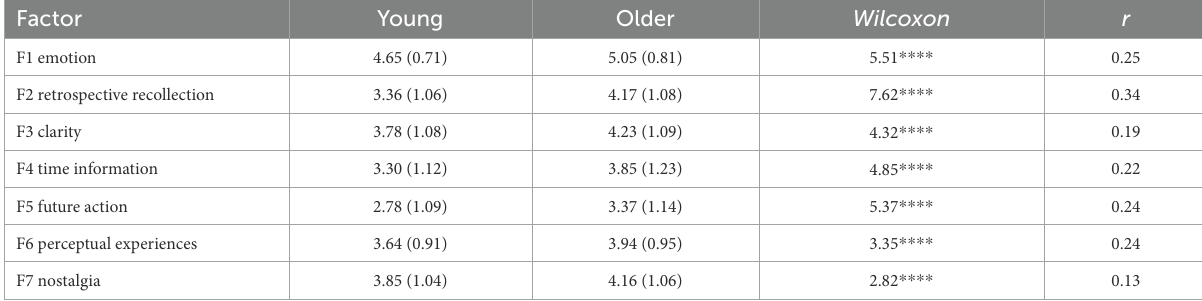
TABLE 5 Mean score (SD) on OEAMQ by each